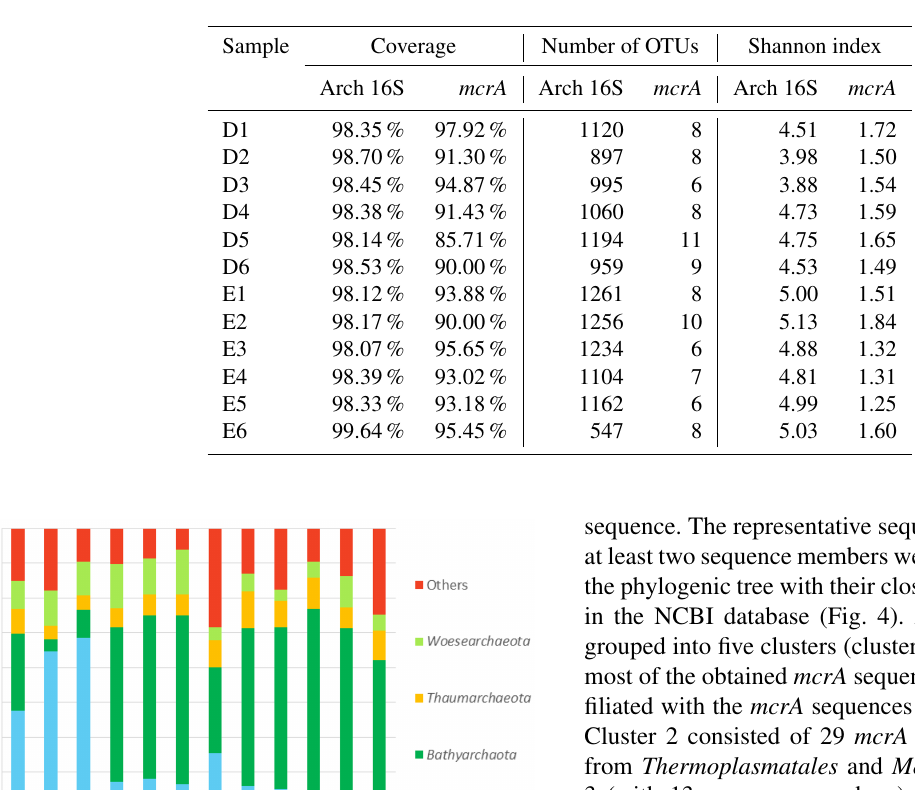
Table 2. Diversity and library coverage of archaeal 16S rRNA and mcrA genes. Samples D1–D6 and E1–E6 were retrieved from Dianchi Lake and Erhai Lake, respectively. Digits “1”–“6” refer to sediment depth 0–5, 5–8, 8–11, 11–14, 14–17, and 17–20cm, respectively.